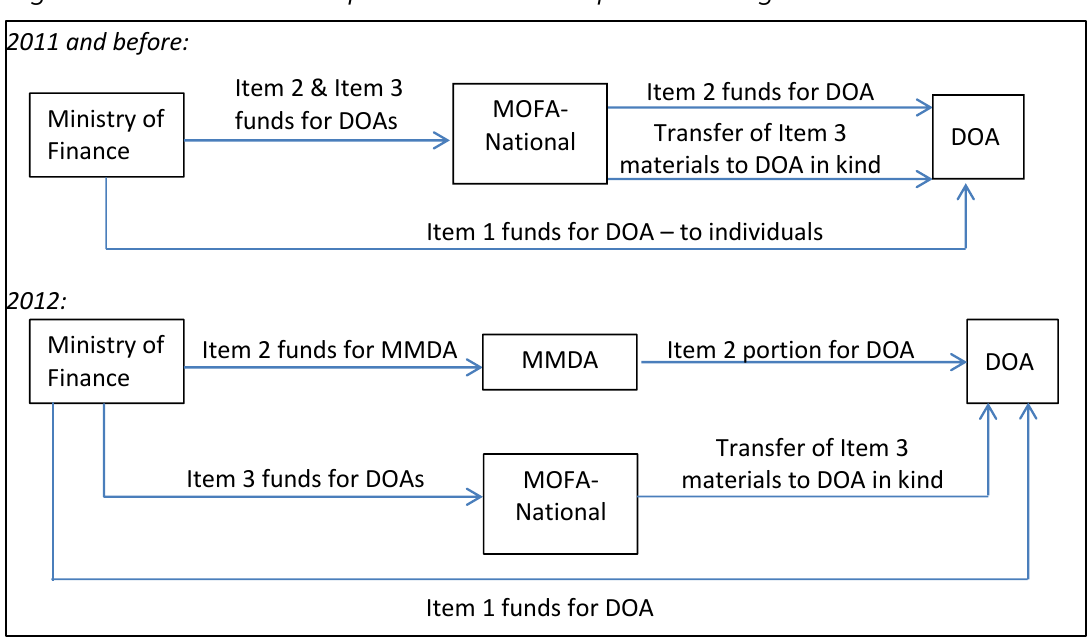
Figure 1: Channel of resource provision to district departments of